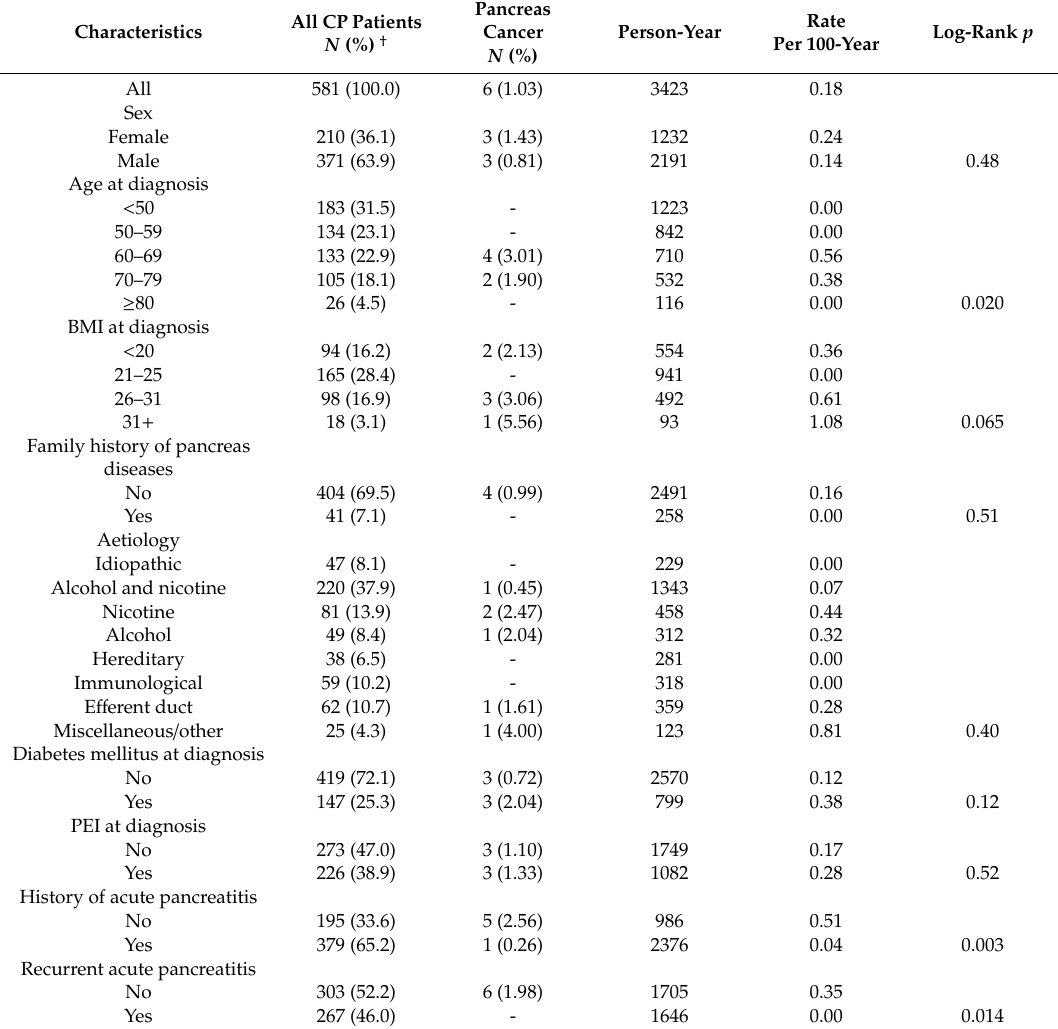
Table 1. Patient